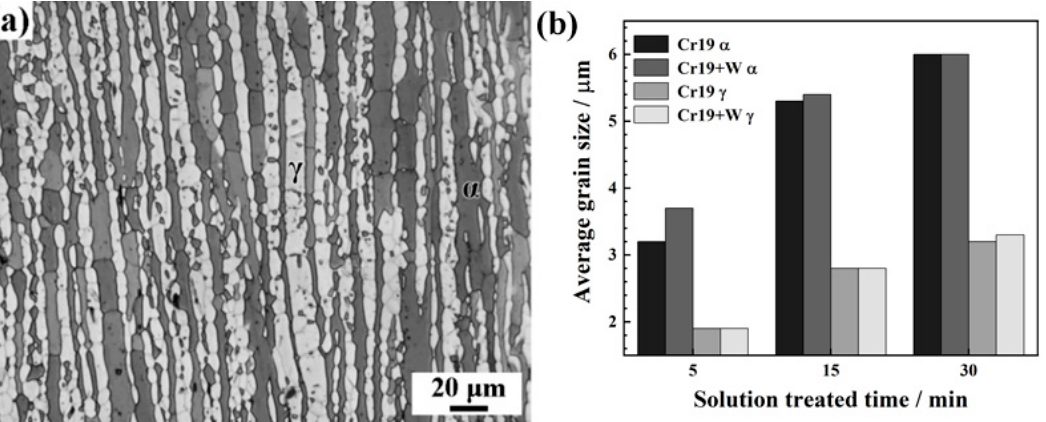
Figure 6. ( a ) The typical optical micrograph after solution treatment at 1050 °C for 30 min of Cr19 + W DSS, and ( b ) variations of the average grain size of α and γ phases in Cr19 and Cr19 + W DSS after solution treatment at 1050 °C for 5, 15, 30 min.